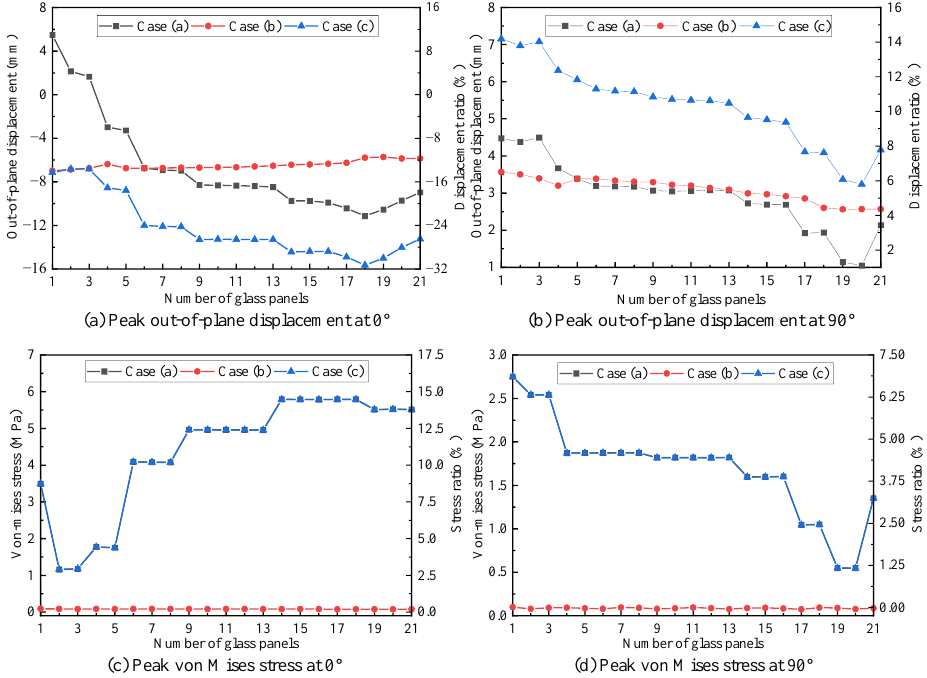
Number of glass panels (c) Peak von Mises stress at 0° Figure 11. Peak responses of inner glass Figure 11. Peak responses of inner glass panels.